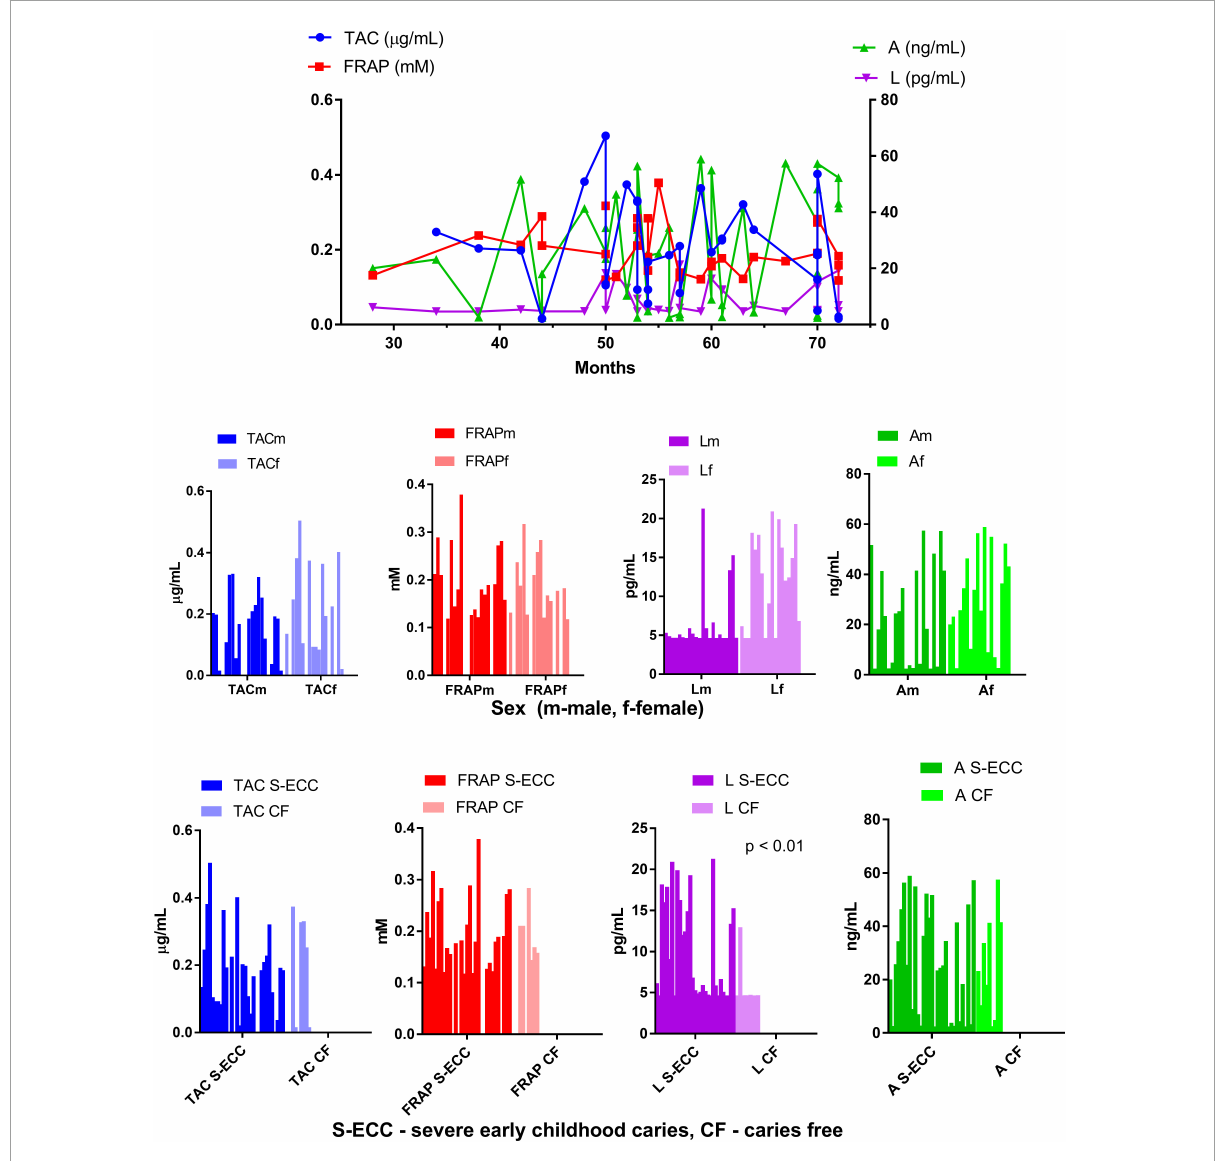
FIGURE1 Antioxidant capacity of saliva supernatant measured in patients of different age, sex, and with and without severe early childhood